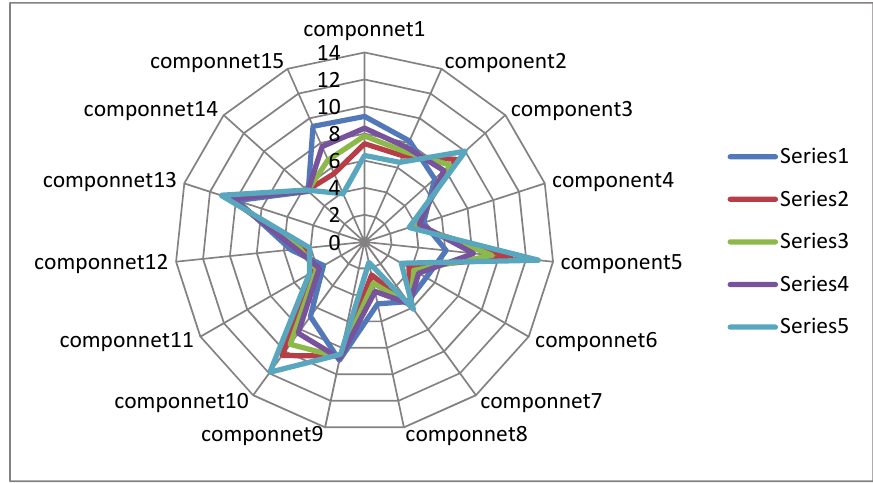
Fig. 5. Variations in ranking using objective, subjective and combined